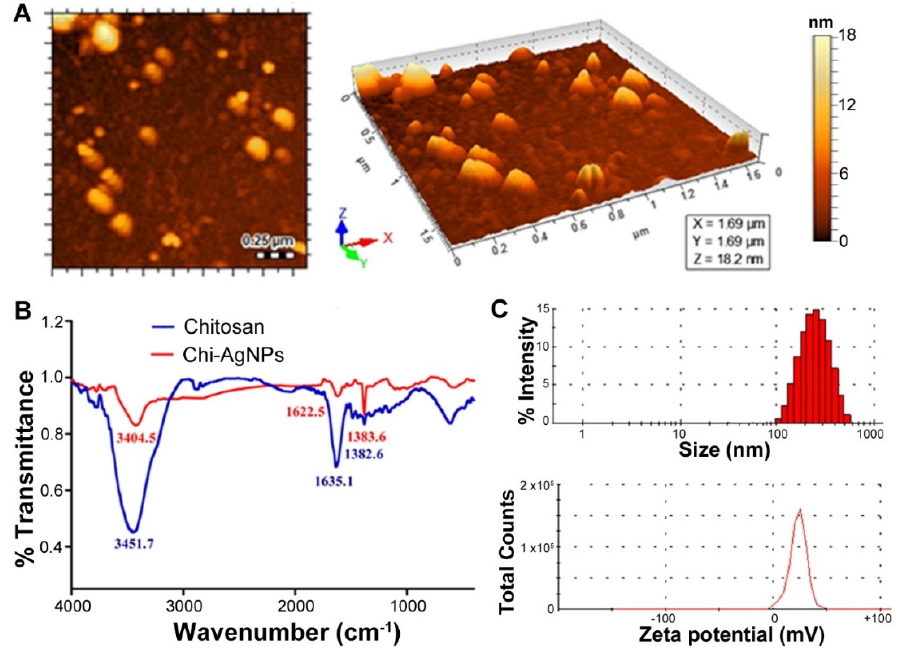
Figure 2. Characterization of Chi-AgNPs. ( A ) surface morphological analysis of synthesized Chi-AgNPs and ( B ) FT-IR analysis of chitosan and Chi-AgNPs; ( C ) analysis of synthesized Chi-AgNPs for size distribution and Zeta potential.